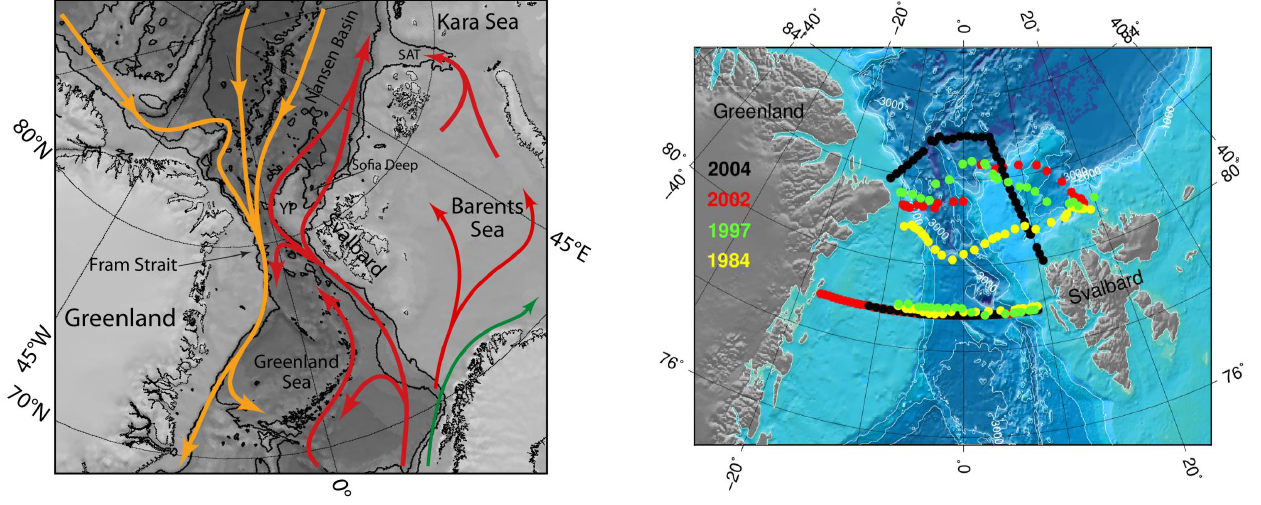
Fig. 2. Fram Strait bathymetry (IBCAO) with 1984, 1997, 2002 and Fig. 2 2004 stations. Map produced with GMT (Wessel and Smith,